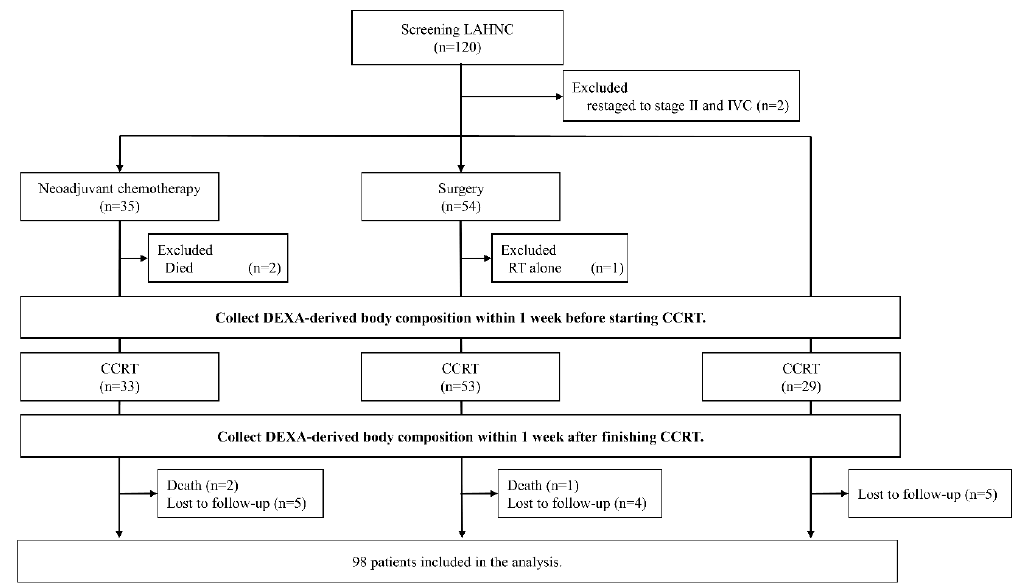
Figure 1. CONSORT diagram. Patients were considered to have completed planned therapy if they received at least 4 cycles of weekly cisplatin at 40 mg/m 2 concomitant with radiotherapy (64–72 Gy). Lost to follow-up indicated patients who did not complete the Dual-energy X-ray absorptiometry (DXA) examination as scheduled. HNC, head and neck cancer; RT, radiotherapy; DXA, dual-energy X-ray absorptiometry; CCRT, concurrent chemoradiotherapy. Table 1. Baseline characteristics of patients with locally advanced head and neck cancer (LAHNC) undergoing concur- rent chemoradiotherapy (CCRT).